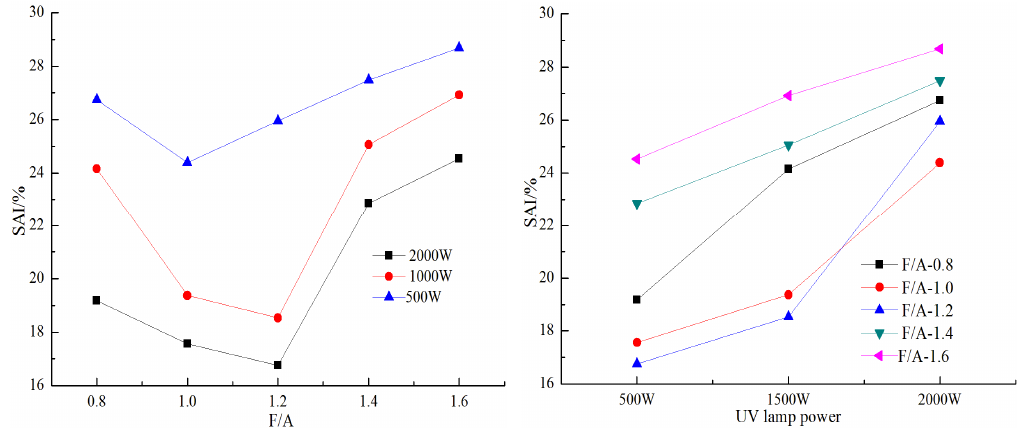
Figure 16. The SAI value of asphalt mortar.